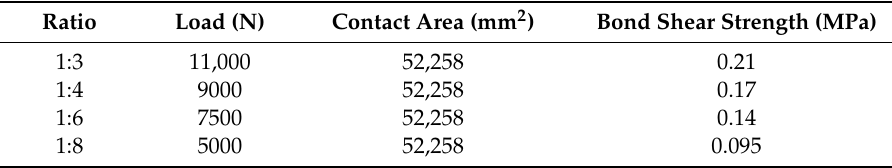
Table 5. Brick masonry triplet shear strength.